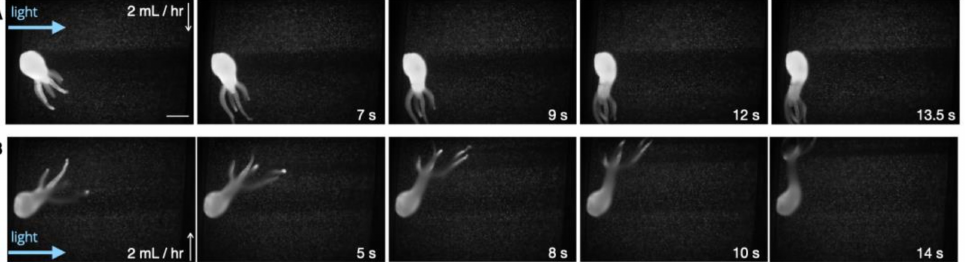
Figure 4. Response to flow. Our results suggested that Hydra typically bend and sway their tentacles in the direction of the flow (head aways from the direction of the flow). ( A ) Initiation of the flow and redirection of the animal towards the flow. The white arrow demonstrates the flow direction. The scale bar is 0.5 mm. ( B ) Reversing the flow direction led to the animal redirecting with the new flow direction.